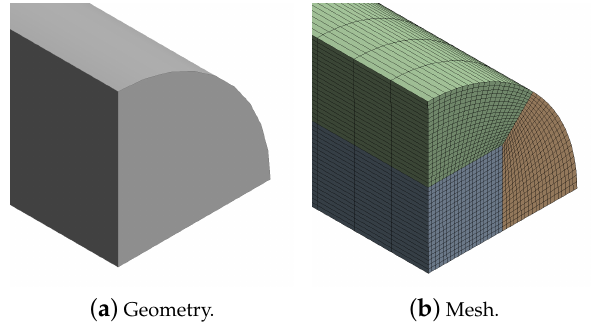
Figure 4. CFD model of the fluid domain in the